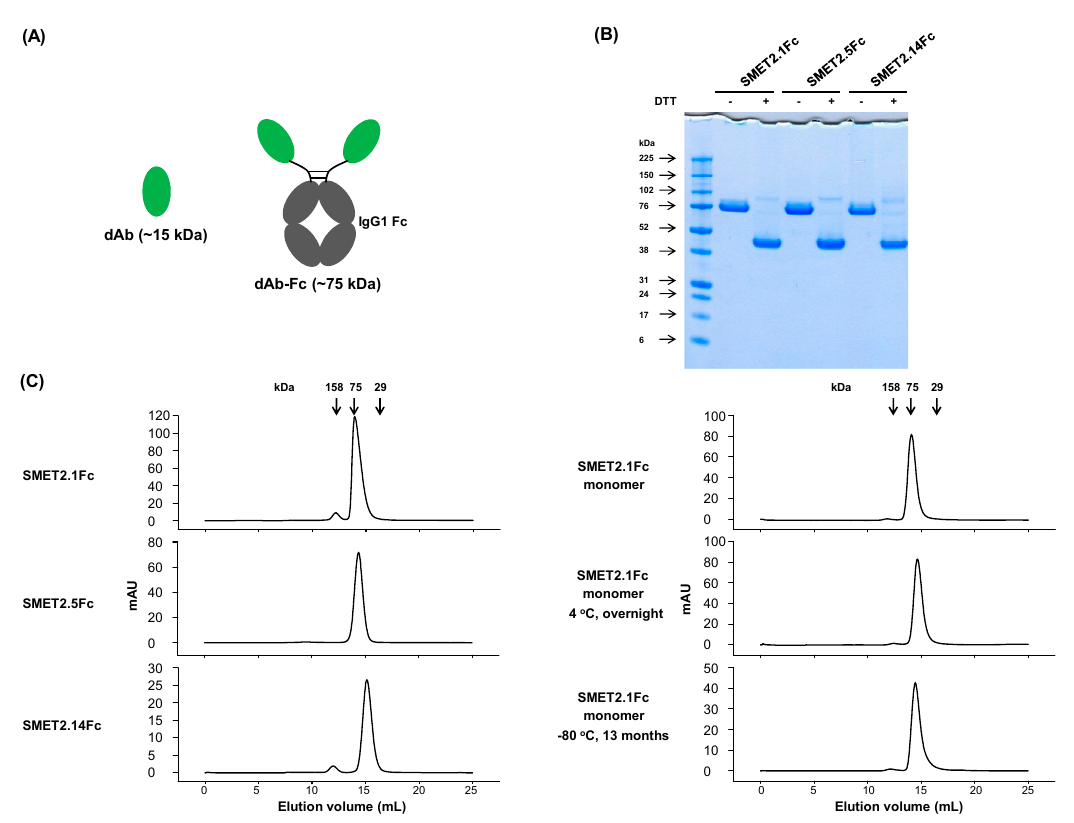
Figure 2. Generation and initial characterization of Fc-fusion proteins of anti-HER2 dAbs. ( A ) Schematic representation of dAb-Fc fusion proteins. Estimated molecular weights of dAbs and dAb-Fc fusion proteins are shown in parenthesis. ( B ) Non-reducing and reducing SDS-PAGE of the dAb-Fc fusion proteins. Molecular masses of the standards are shown on the left. ( C ) Size-exclusion chromatography of the dAb-Fc fusion proteins. The arrows at the top indicate the elution volumes of the molecular mass standards in PBS (pH 7.4).